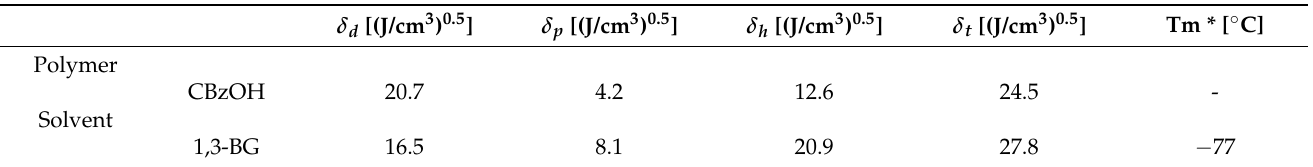
Table A4. The HSP of CBzOH and CTA polymer and selected solvent used in the membrane preparation by TIPS method